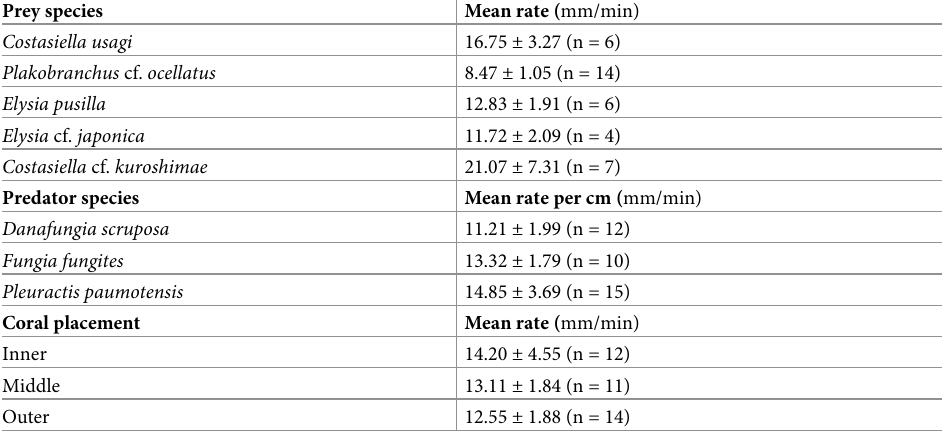
Table 5. Mean rates of transport of prey items to the mouth of different mushroom coral species. All different prey species were tested upon all predator coral species. Rates shown include both in-situ and ex-situ